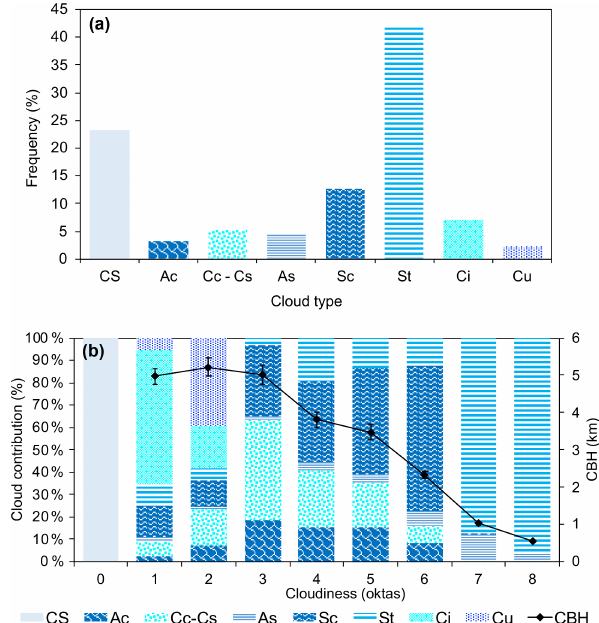
Figure 7. (a) Time frequency (%) of the cloud type classified over the U9 site (CS means clear-sky conditions); (b) contribution (%) of each cloud type to the okta values measured over the U9 site.